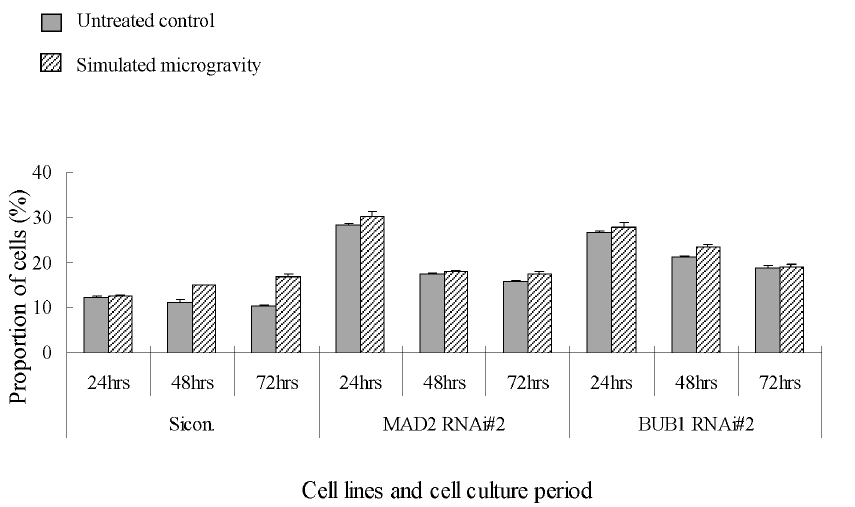
Figure 12. G2 phase changes in U-2 OS cells knocked down for MAD2 or BUB1 under simulated microgravity. For sicon. clone, the cell number in G2 phase increase with the extension of simulated microgravity, and 3.7% and 6.5% higher than untreated control under simulated microgravity for 48 hours and 72 hours, respectively. For MAD2 or BUB1 RNAi clones, the cell number in G2 phase under simulated microgravity is also higher than untreated control, but only 1–2% higher than untreated control.